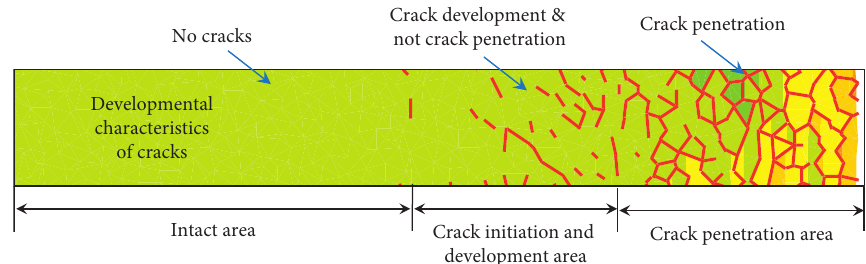
Figure 11: The division principle of the three